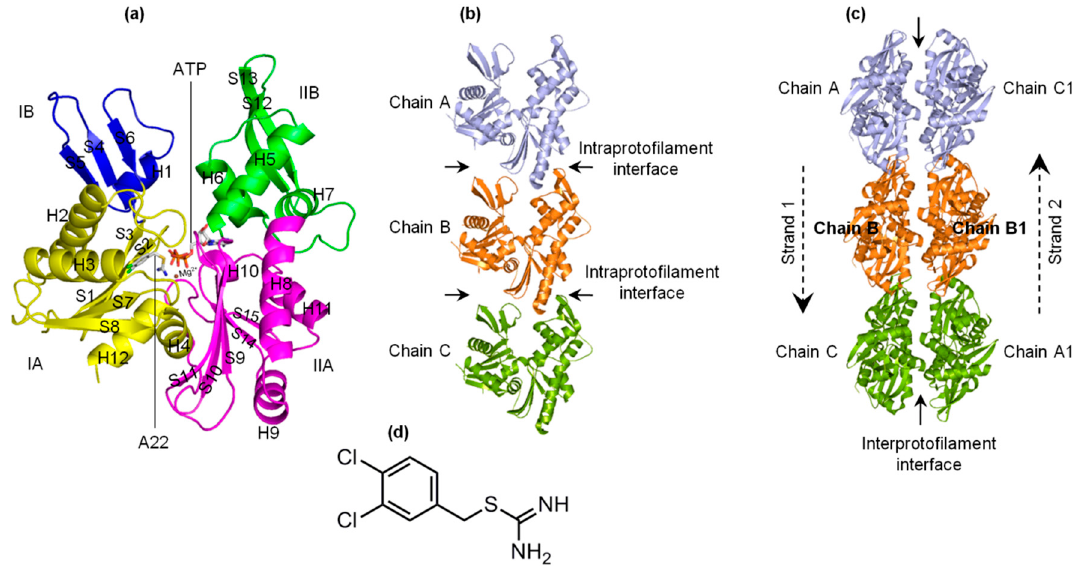
Figure 1. Forms of MreB and structure of A22. ( a ) Monomeric structure of MreB. Subdomains IA, IB, IIA, and IIB as well as the ATP and A22 binding sites are indicated. The α -helix and β -sheet secondary structural elements are labeled. ( b ) Structure of a single protofilament of MreB composing of chains A, B, and C. The intraprotofilament interfaces are indicated. ( c ) Structure of double protofilament of MreB. The antiparallel strands and the interprotofilament interface are shown. ( d ) Structure of A22.